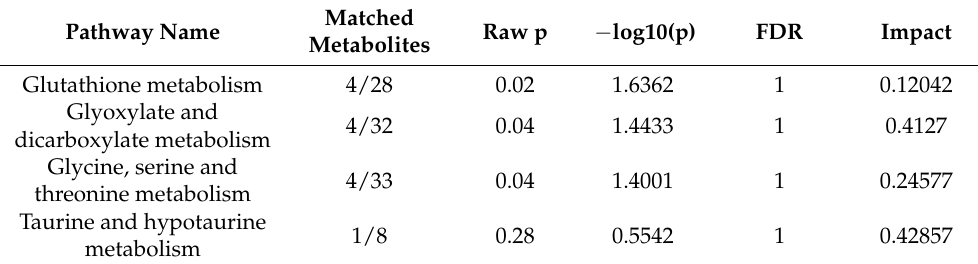
Table 4. Metabolic pathway analysis of metabolites identified by